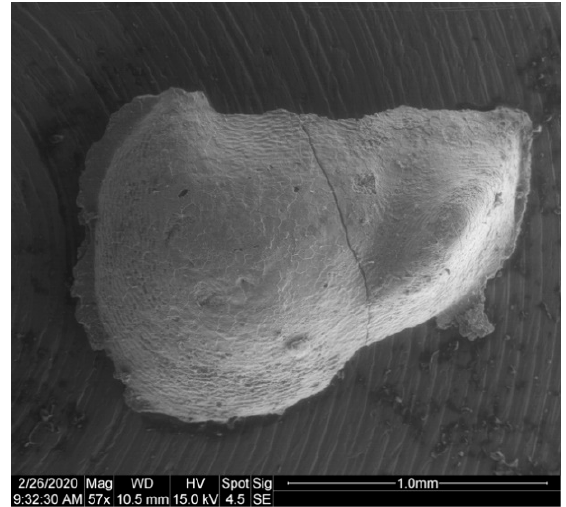
Figure 31. Cambroarchilocus tigris gen. nov. sp. nov. Holotype. Left shield, anterior to left. IGM 3614 (42). Photo Credit: Mark